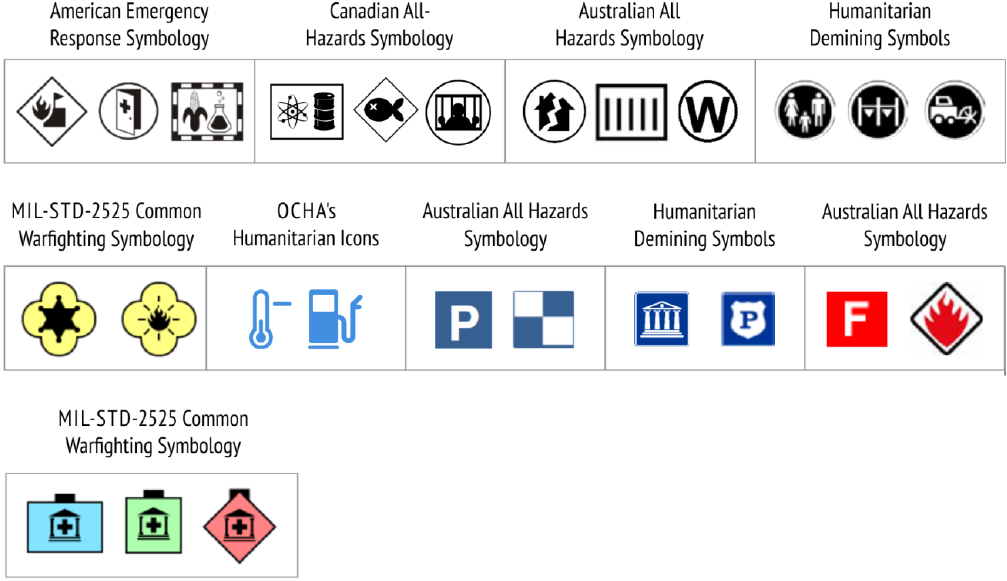
Figure 8. Examples of the contrast and prominence of pictograms set against the colour hue inside the symbol (fill) in the analysed sets.